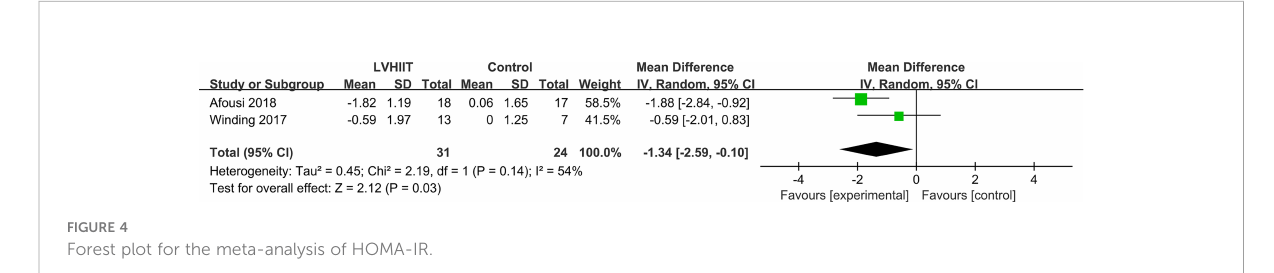
FIGURE 4 Forest plot for the meta-analysis of